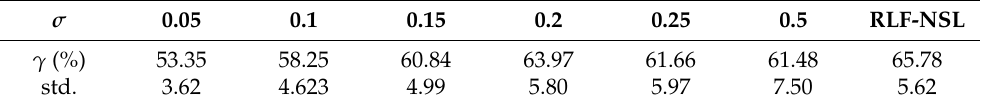
Table A5. The classification accuracy γ and the standard deviation(std.) on the IMDb for N = 100 by the NSL with the Guassian and RLF kernels. For the Guassian kernel, we vary σ from 0.05 to 0.5. For the RLF-NSL, we take β = 1.06.